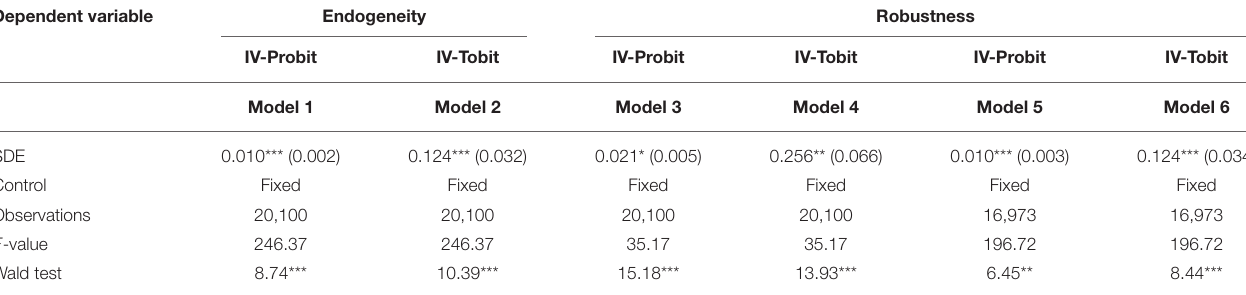
TABLE 5 | Results of robustness